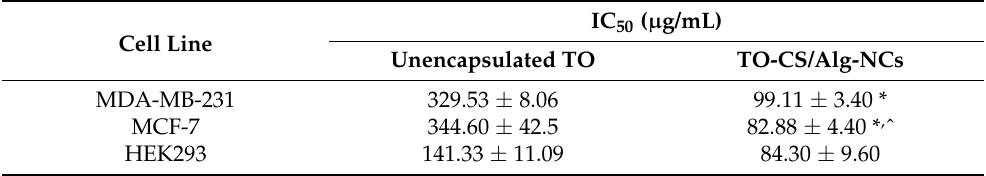
Table 2. Mean IC 50 values of unencapsulated TO and TO-CS/Alg-NCs against MDA-MB-231, MCF-7, and HEK293 cell